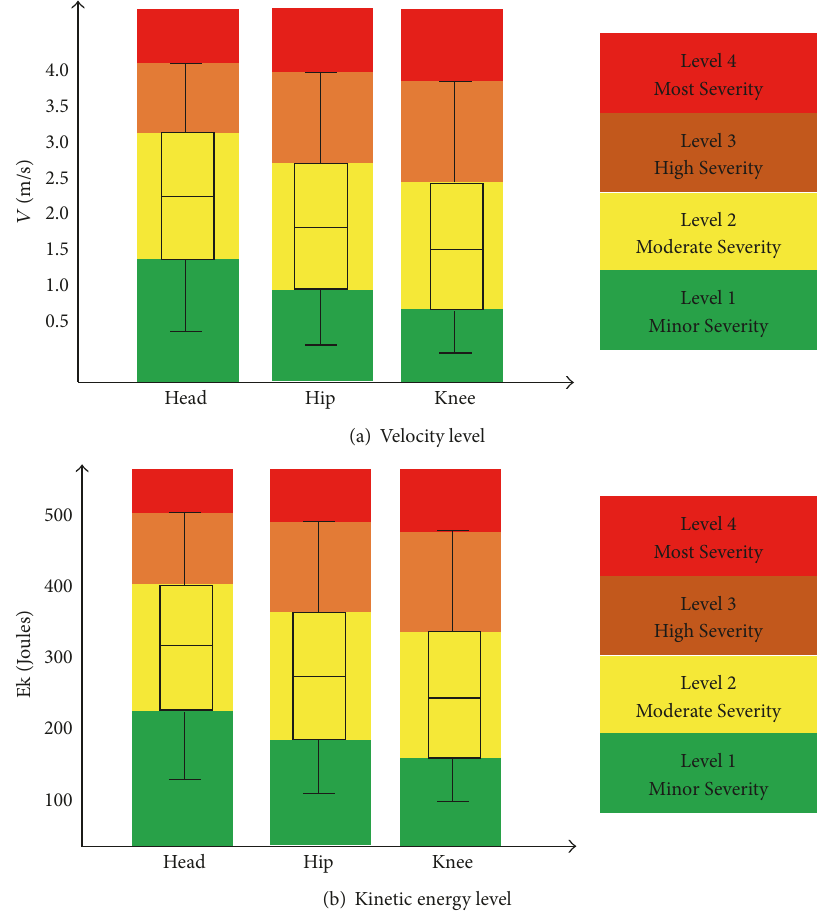
Figure 5: Fall severity criterion